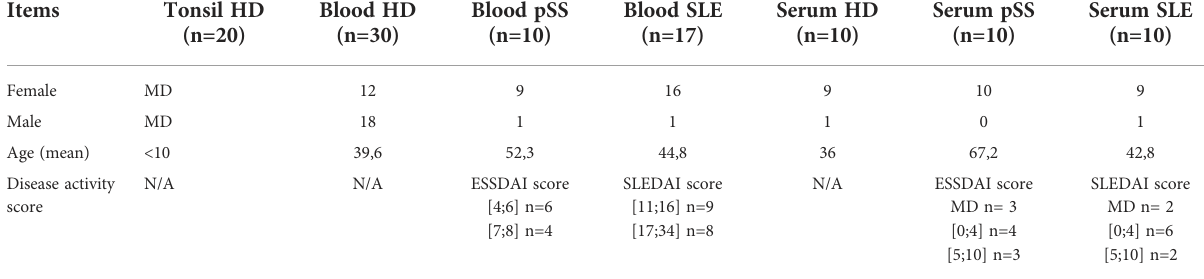
TABLE 1 Demographics and disease activity